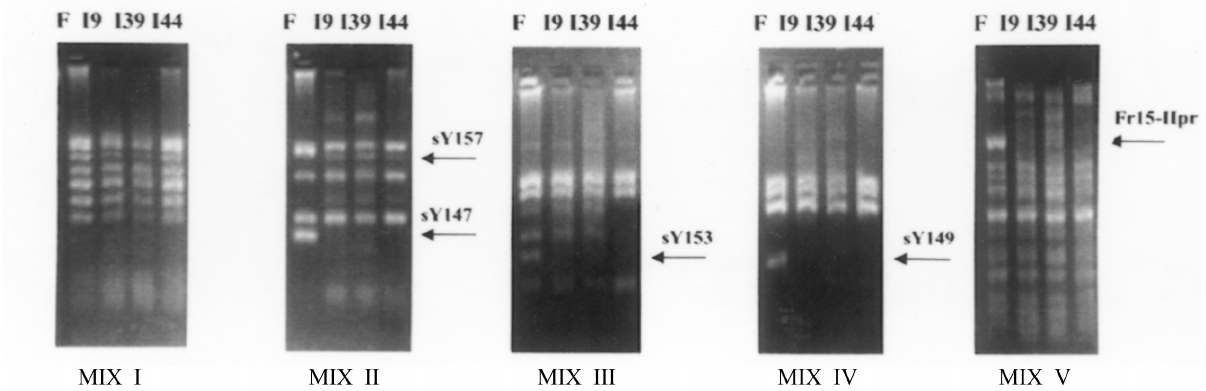
Figure 2 - Yq11 microdeletion analysis by multiplex PCR of 28 STSs distributed in five combinations (Mix I to V). F, fertile male; I-9, I-39, and I-44, in- fertile males, carrying microdeletions. The arrows indicate the STSs amplified only in the control.